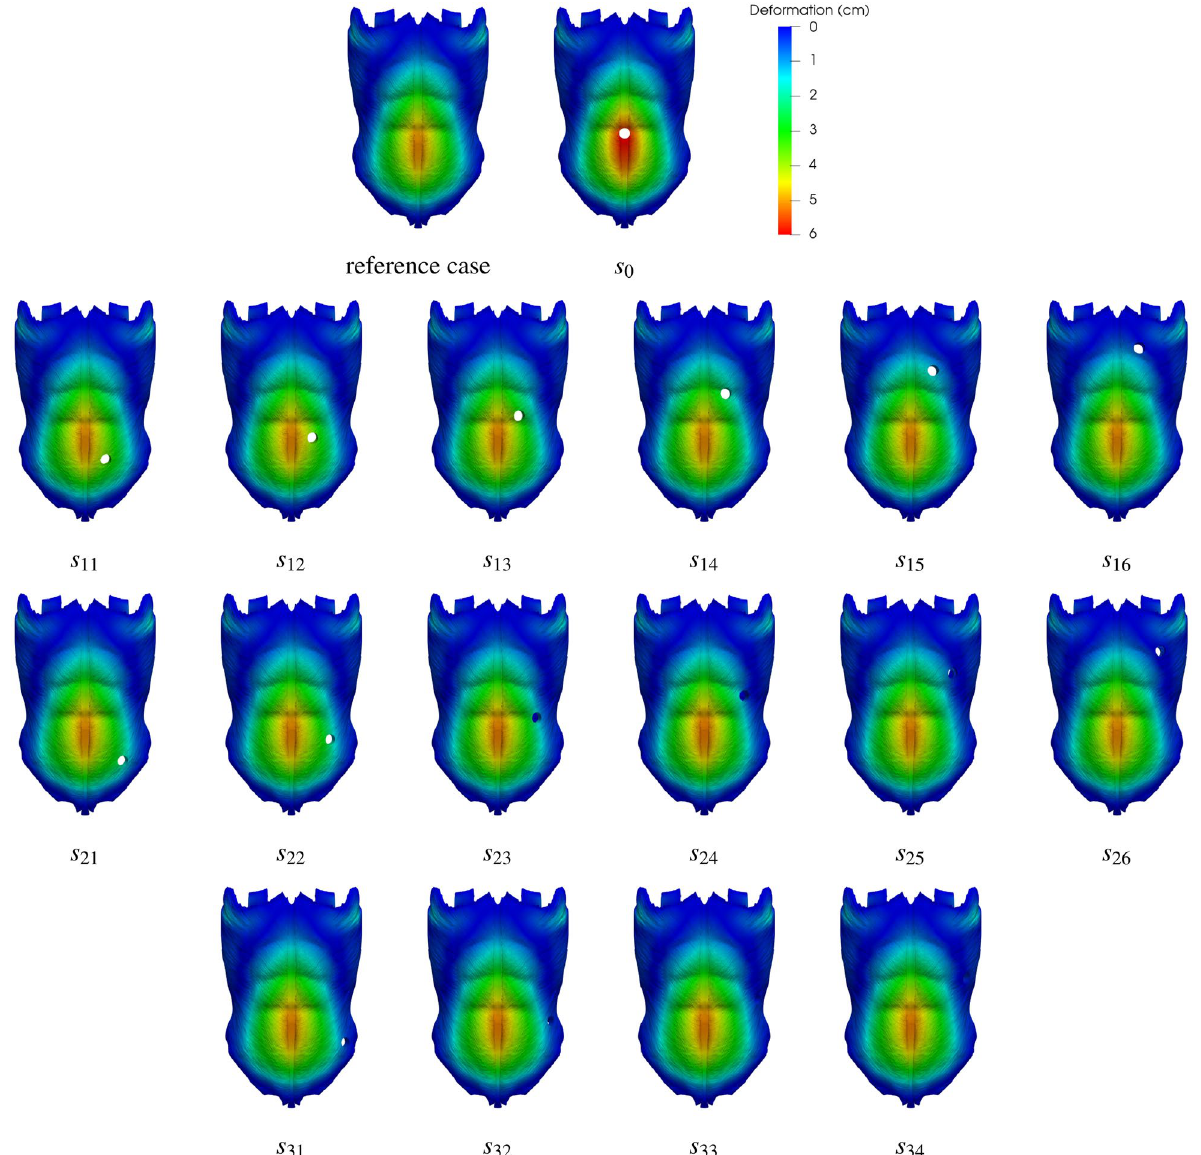
locations. In all cases, the results correspond to the simulations with the maximum value of the applied intraabdominal pressure, P = 20